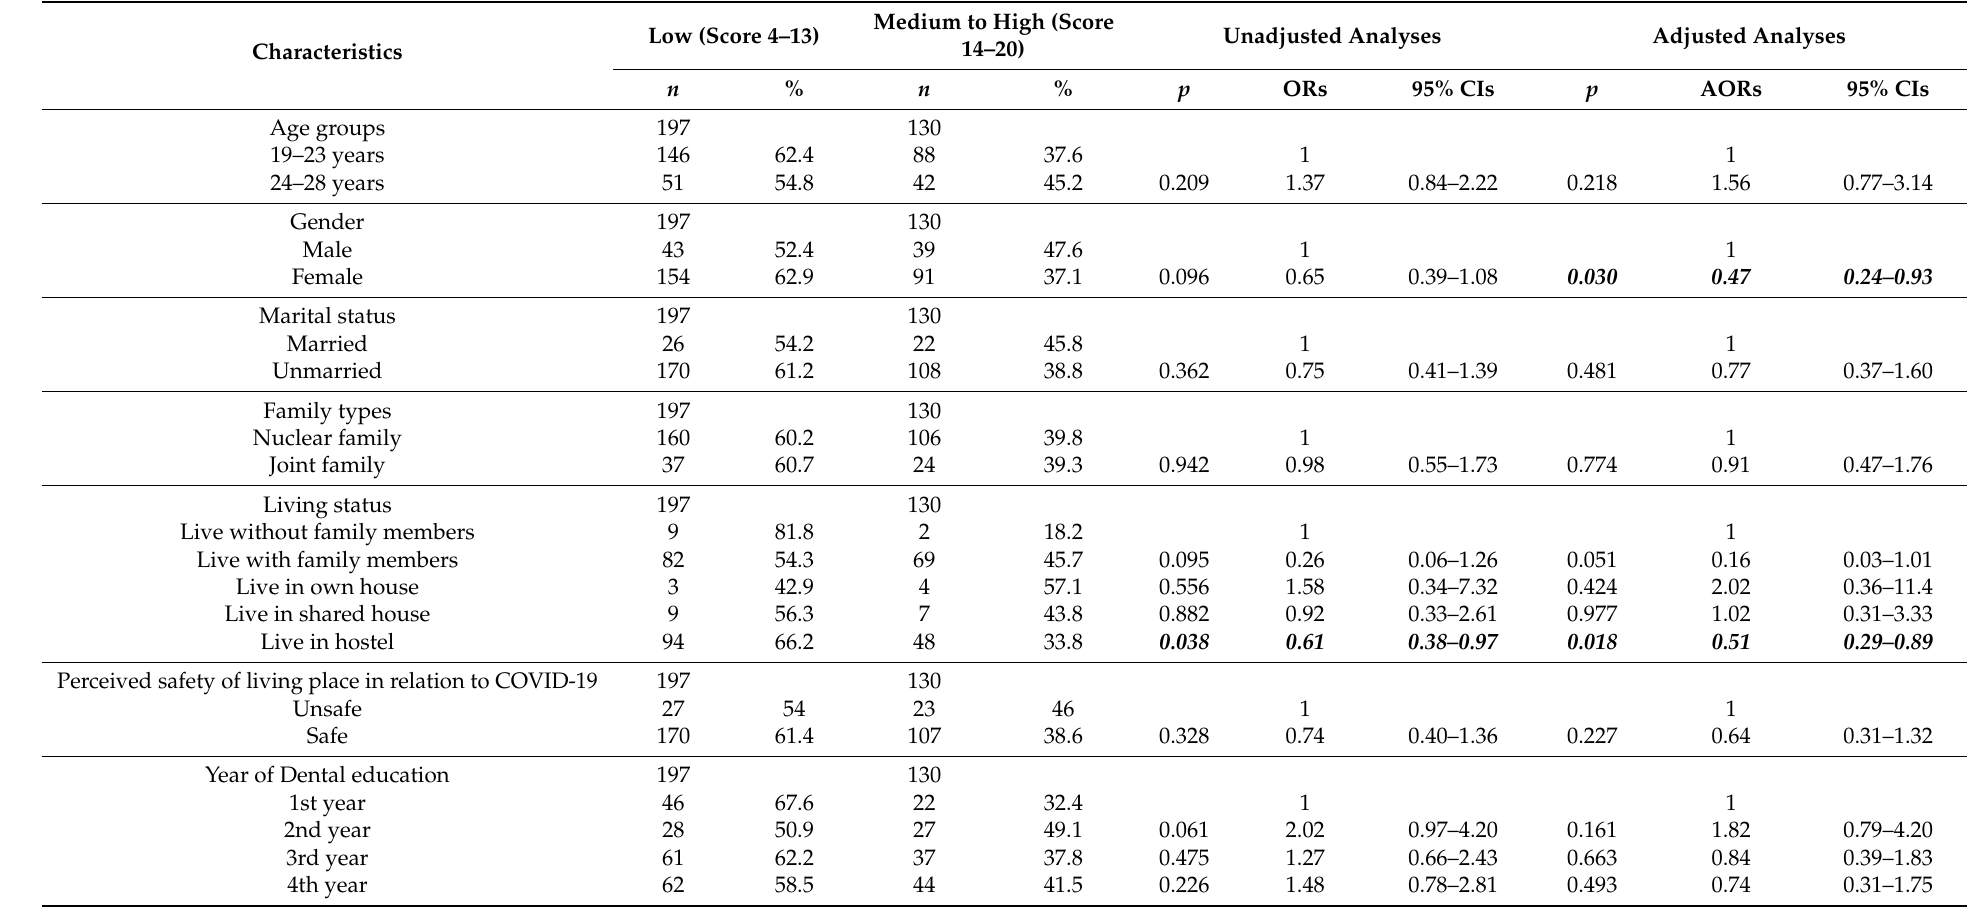
Table 7. Predictors for coping among the study population (based on BRCS